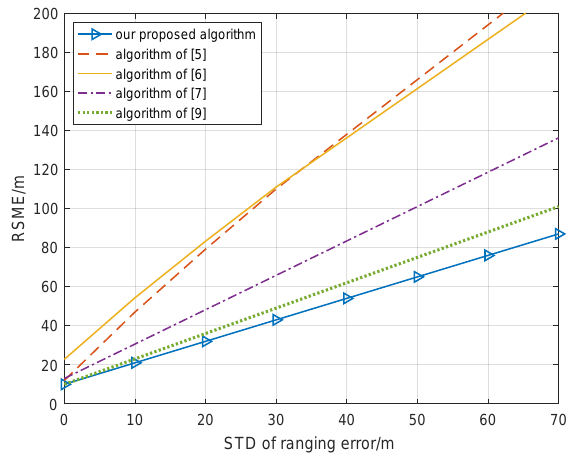
Figure 3. Relationship cooperative position error and ranging error with STD of positioning errors of cooperative nodes of 10